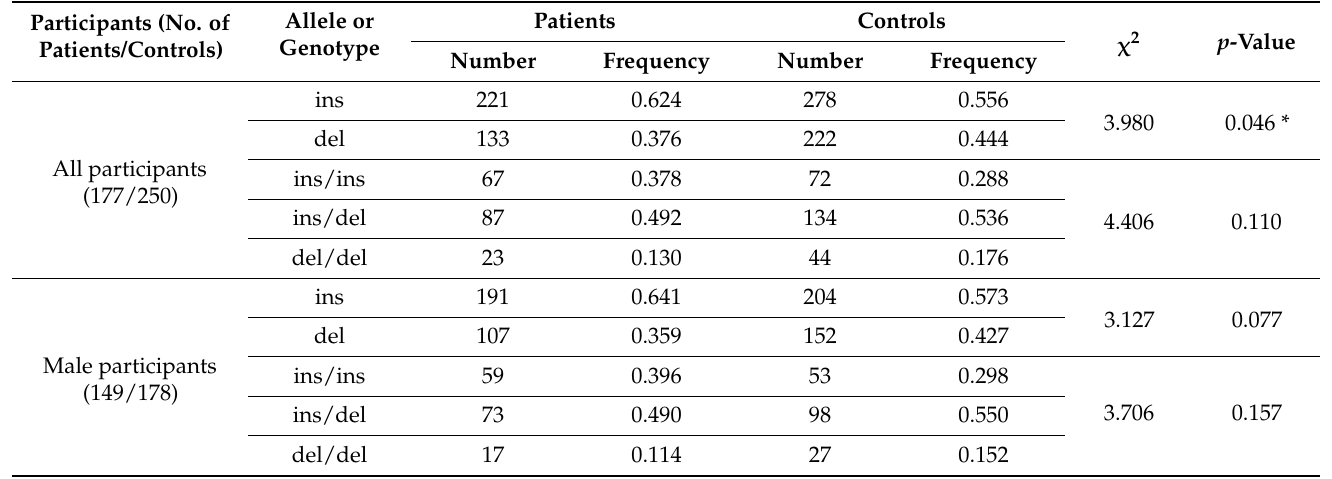
Table 1. Allele and genotype frequencies of the 19-bp ins/del alleles in the DBH gene compared between patients and normal